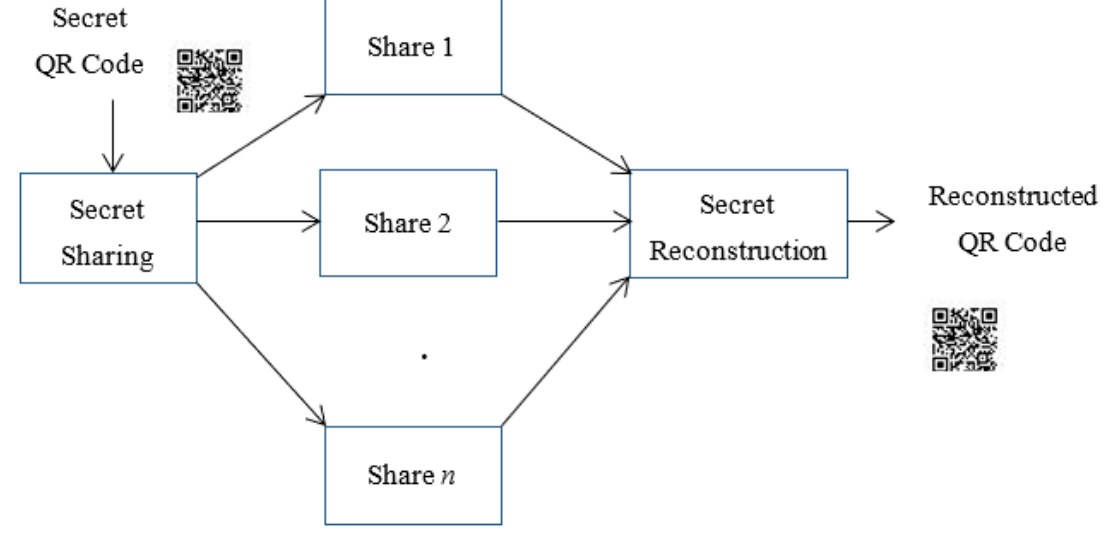
Figure 1. (n , n) QR code sharing.